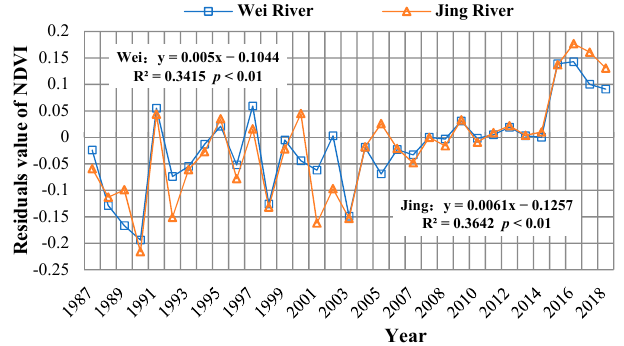
Figure 10. The trend of NDVI residuals in Wei and Jing River basins during 1987–2018.